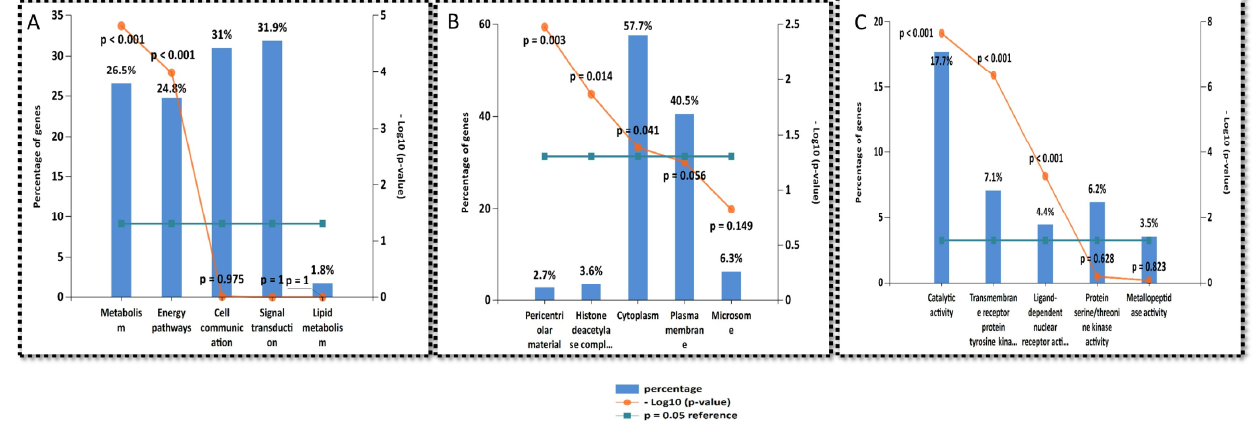
Figure 7. Gene ontology analysis of all target genes of active compounds of Olea europaea L. cv. Picual: ( A ) biological process, ( B ) cellular components, ( C ) molecular functions.